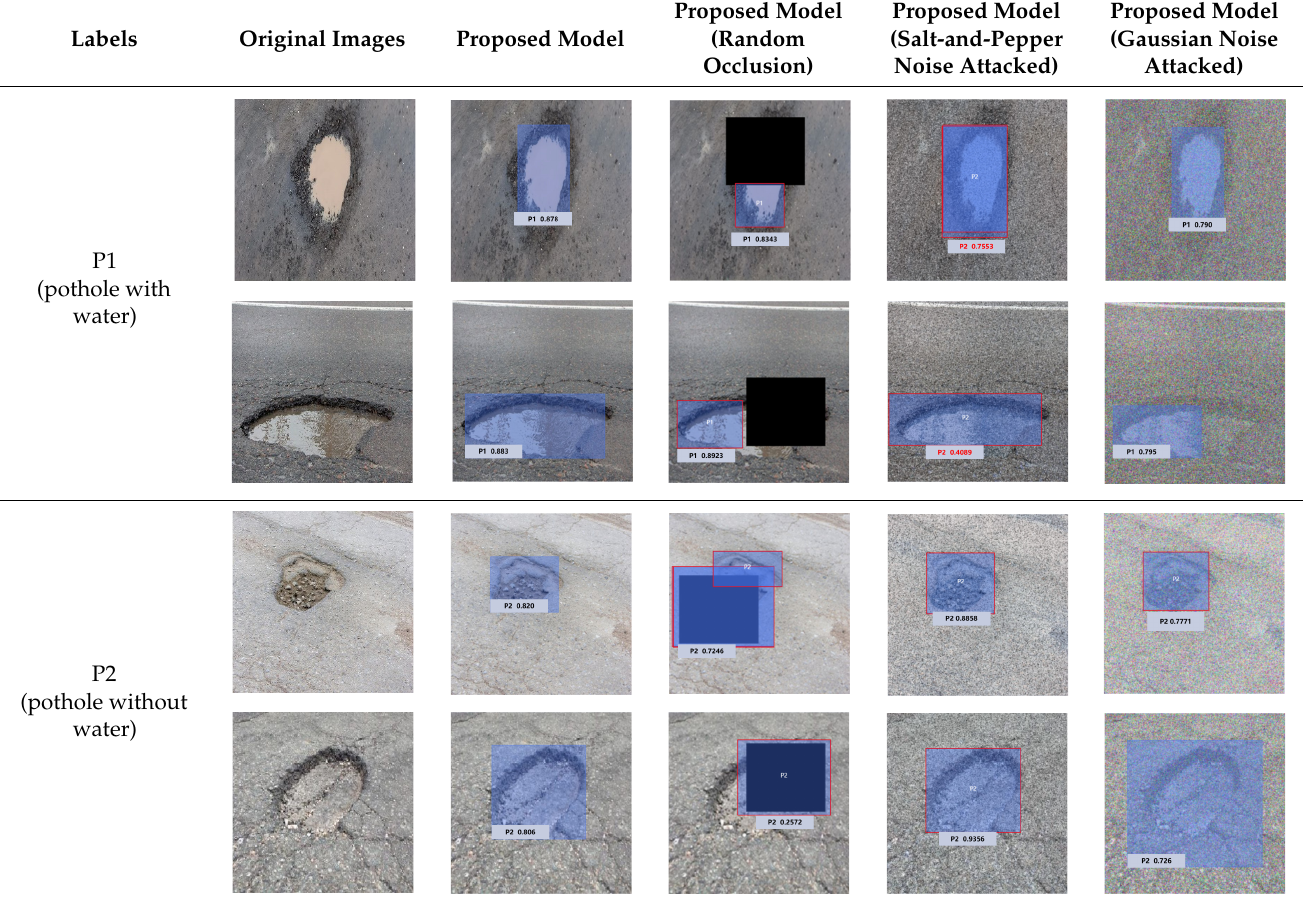
Table 10. Examples of detection results of the attacked pothole images.